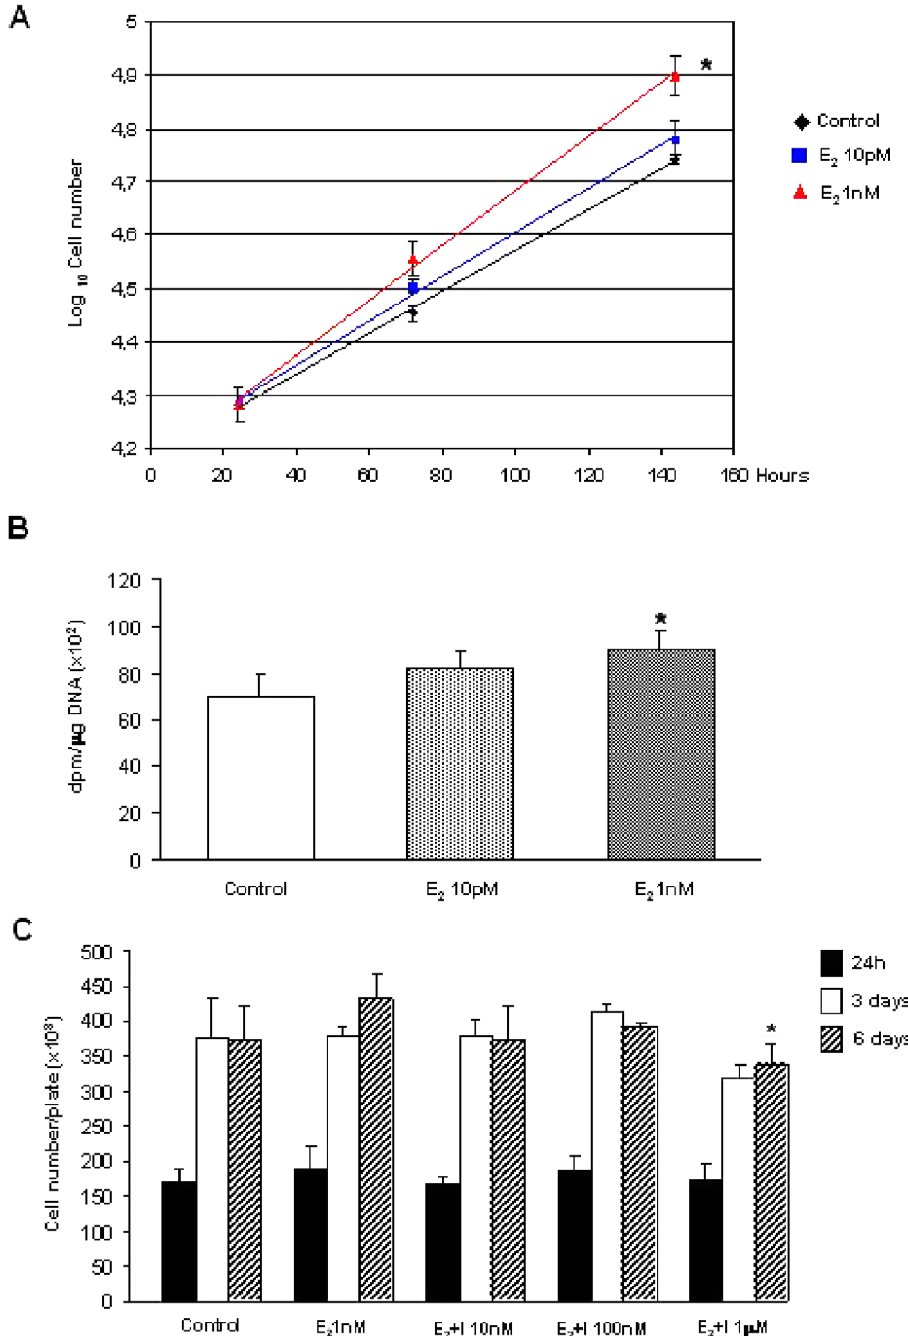
Fig. 4. Analysis of cell growth and viability of SPNC treated with 17 β E 2 and ICI 182,780. Each bar represents the mean value ± SD of three ex- periments. (A and C) Cell number evaluation by a Bürker haemocytometer chamber. * p < 0 . 05 vs . 17 β E 2 1 nM-treated cells. (B) [ 3 H]-thymidine incorporation assay. * p < 0 . 05 vs . untreated